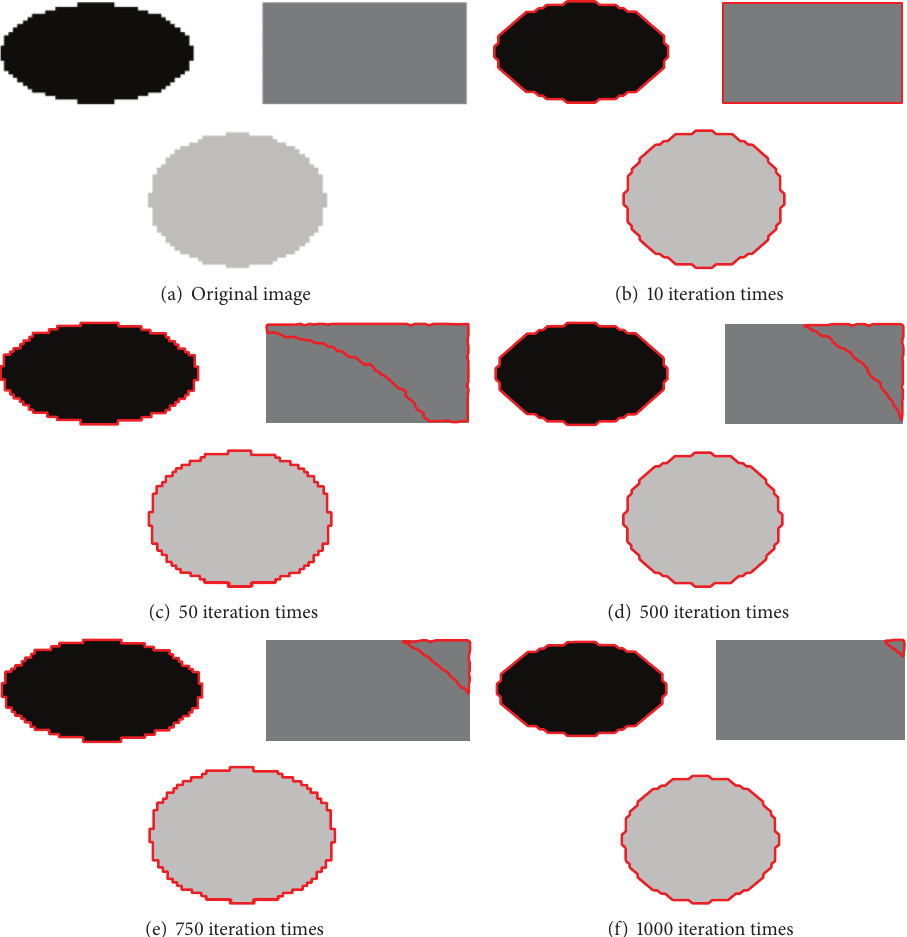
Figure 1: Multiobject image segmentation at 𝑘 = 1 ( 𝜆 1 = 𝜆 2 = 10 , Δ𝑡 = 10